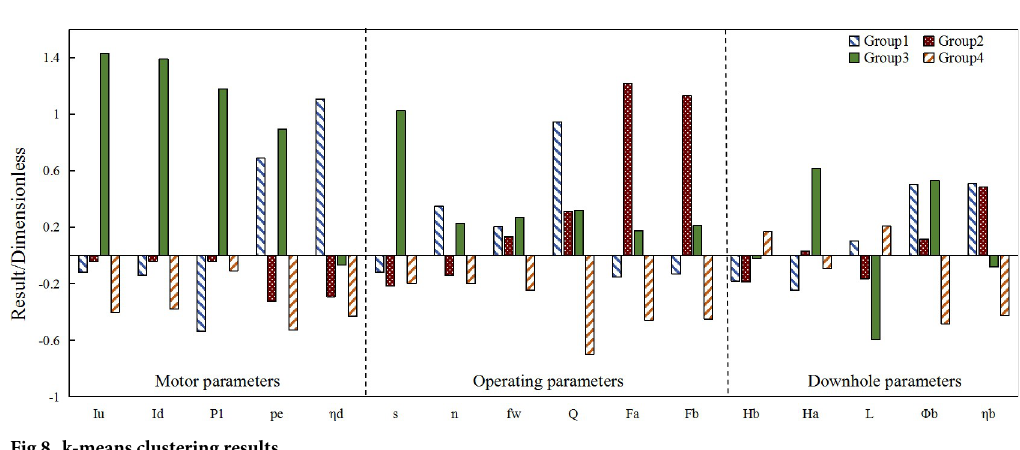
Fig 8. k-means clustering